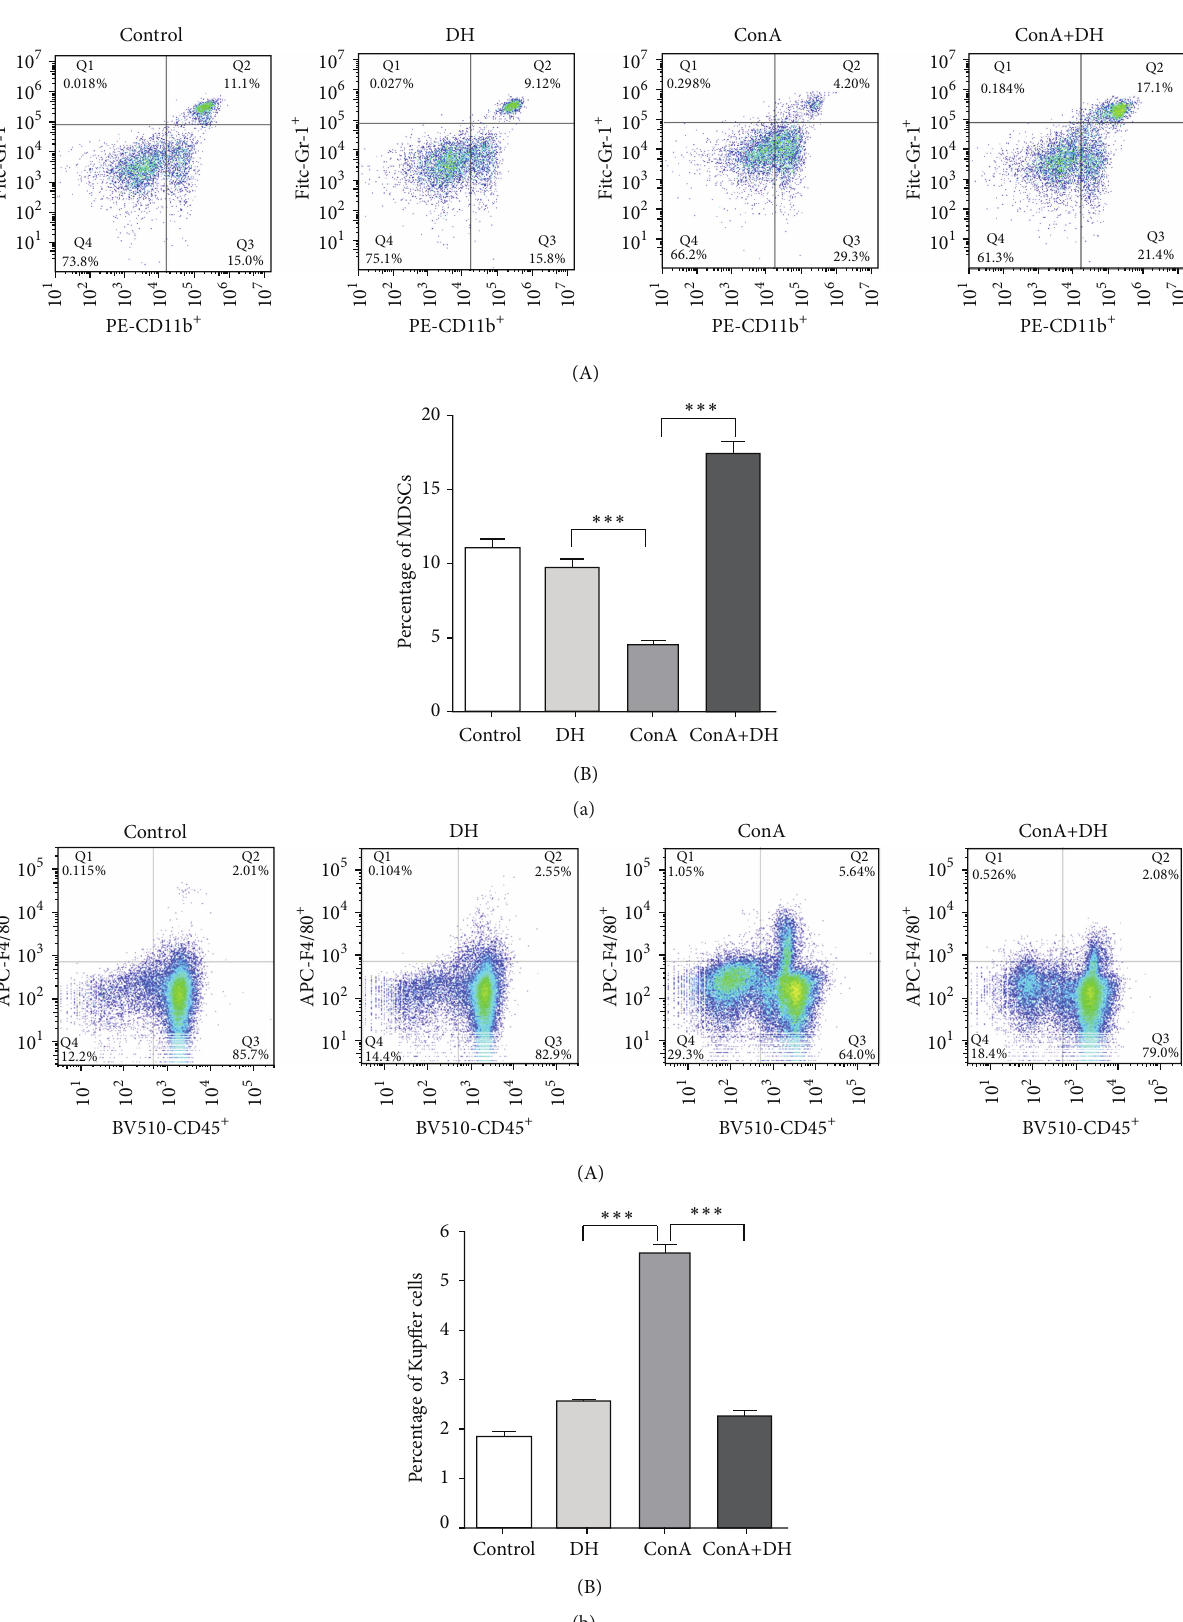
Figure 6: DH recruits more MDSCs to liver and inhibits the infiltration of macrophages in liver. Notes: hepatitis was induced by i.v. injection of ConA (15mg/kg). Liver mononuclear cells were isolated from mice at 18h following ConA injection. CD11b + Gr1 + MDSCs (a) and CD45 + F4/80 + Kupffer cells (b) were stained and analyzed by flow cytometer. Numbers in quadrants indicate the percentage of cells in each ((a)(A) and(b)(A)).ProportionsofCD11b + Gr1 + MDSCs(a)(B)andCD45 + F4/80 + Kupffercells(b)(B)amongtotallivermononuclearcellpopulation (mean ± SD 𝑛 = 3 ; ∗∗∗ 𝑃 < 0.0001 ). ConA: Concanavalin A; DH: Dracocephalum heterophyllum ; MDSCs: myeloid-derived suppressor